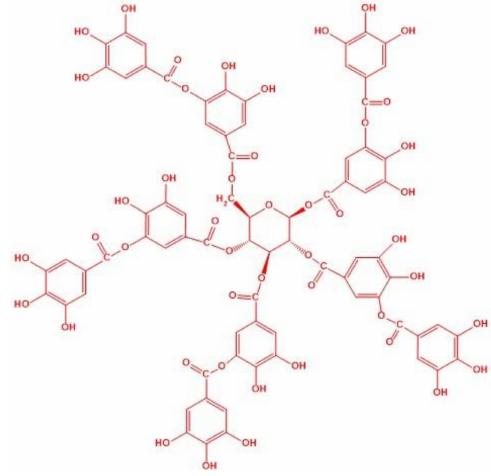
Figure 1. The structure of tannic